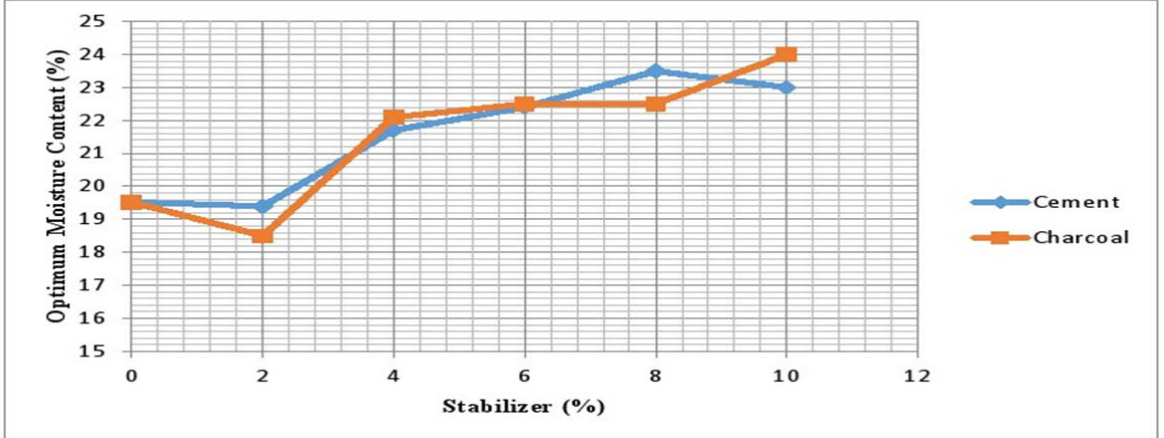
Figure 2. Variation of OMC with percentage of